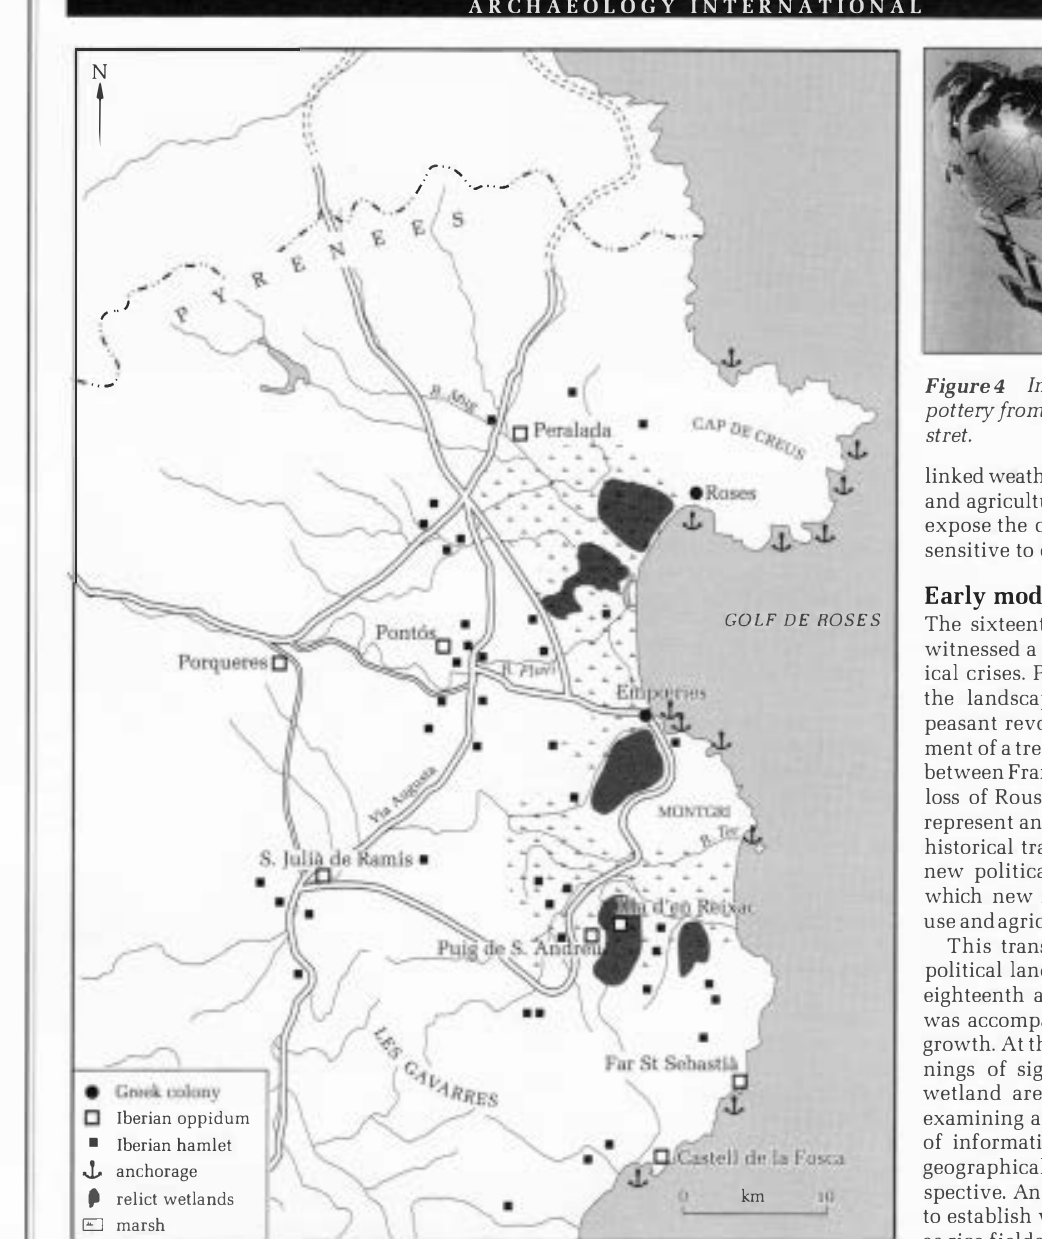
Figure 3 The Late Iron Age cultural landscape of the Emporda, showing settlements, roads and relict wetland areas. authority, and the Emporda, like the rest of Catalonia, became part of the kingdom of the Goths. The ensuing Saracen invasions completed the politico-military breakdown of Roman